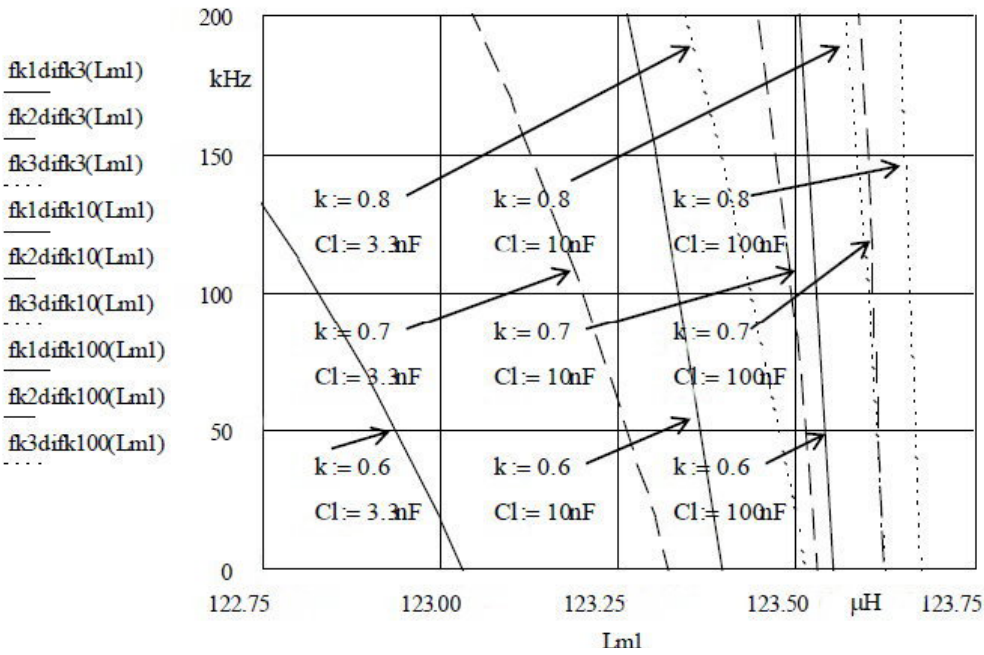
and different C . m1 L